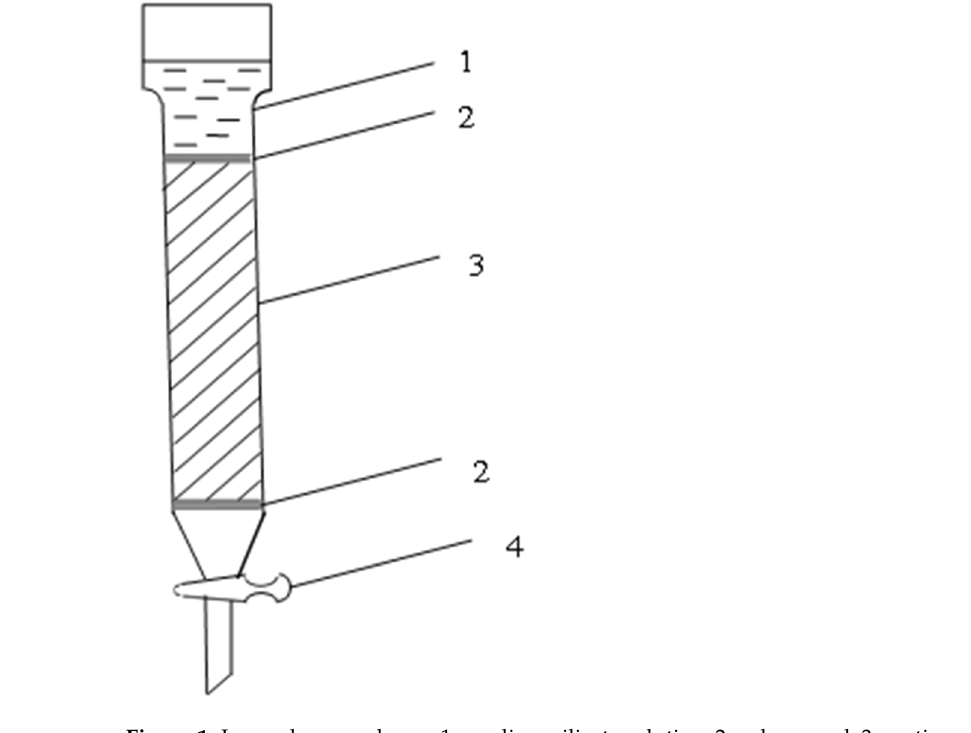
Figure 1. Ion exchange column: 1—sodium silicate solution; 2—glass wool; 3—cation resin; 4—crane. ◦ C A distilled water with density ρ 20 = 0.9982 g/cm 3 and surface tension m σ 20 ◦ C = 72.8 mN/m was used as reference